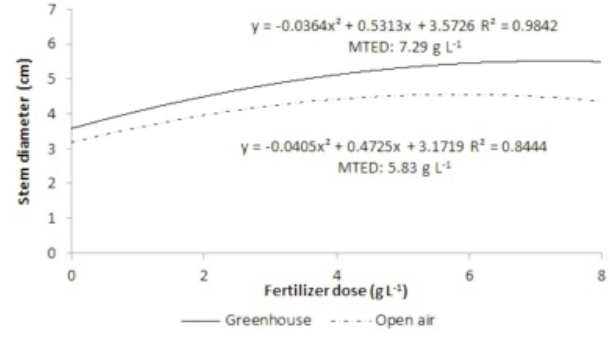
Fig. 2 ­ Stem diameter (mm) of peach plants cv. Capdeboscq, in relation to the dosage of the controlled­release fertilizer (CRF) and two cultivation environments, 90 days after